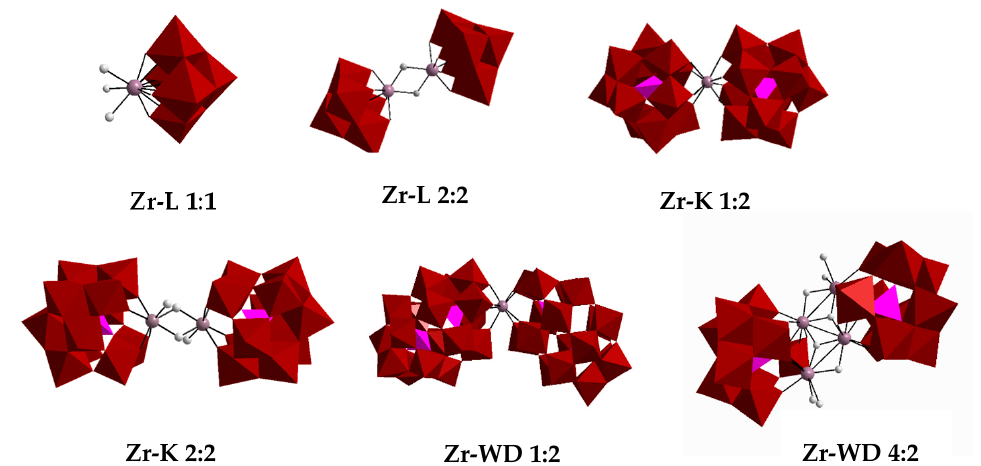
Figure 1. The polyhedral representation of Zr-substituted POMs ( Zr-L 1:1 , Zr-L 2:2 , Zr-K 1:2 , Zr-K 2:2 , Zr-WD 1:2 and Zr-WD 4:2 ). WO 6 and PO 4 are represented by red octahedrons and pink tetrahedrons, respectively. The grey spheres represent Zr(IV) ions.